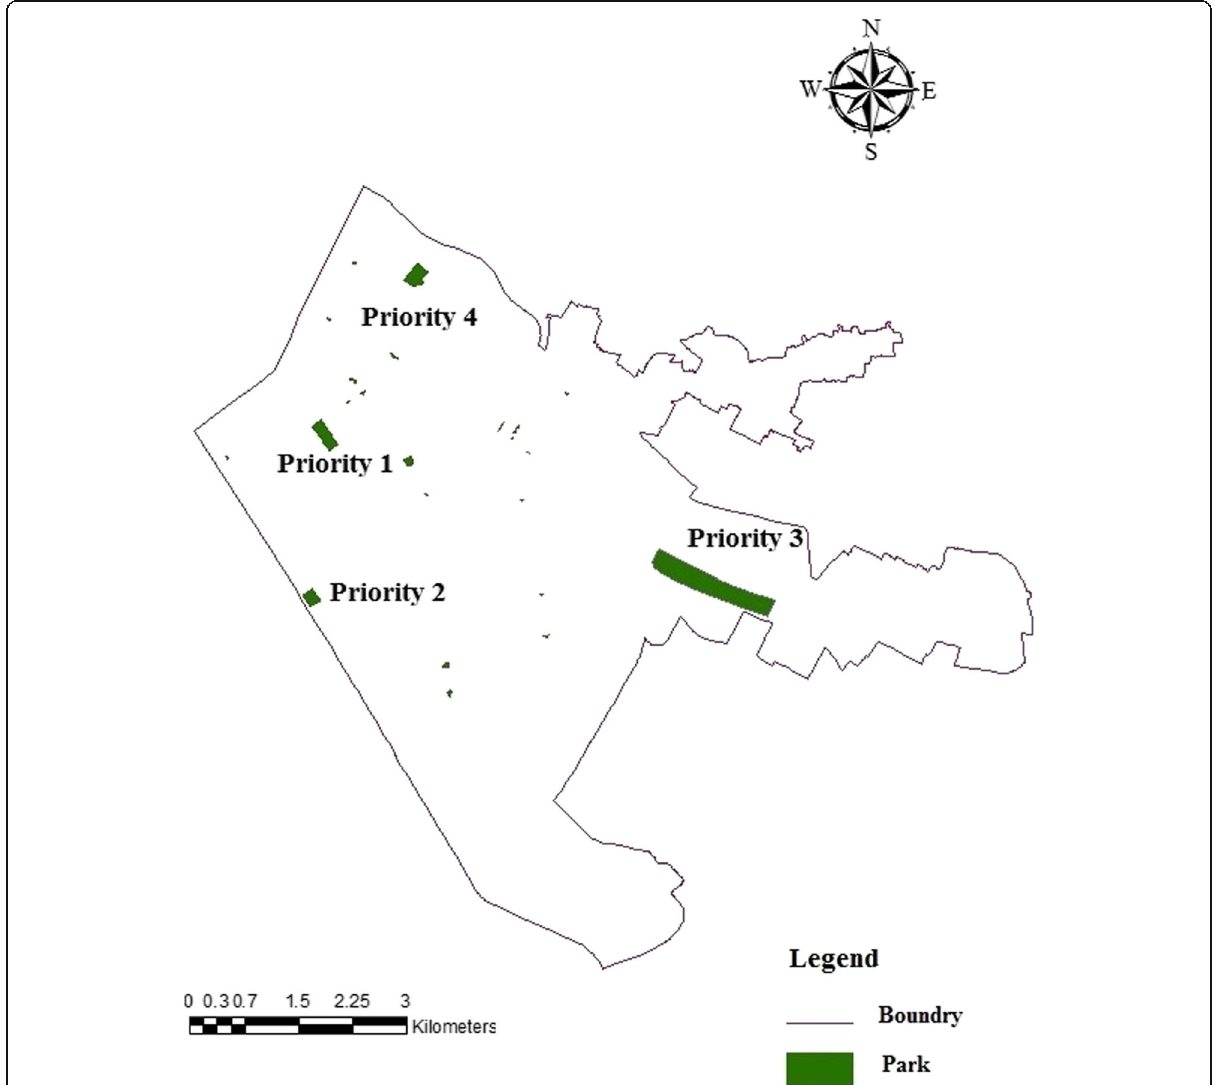
Fig. 15 The final map of accommodation priorities in district 7, Shiraz